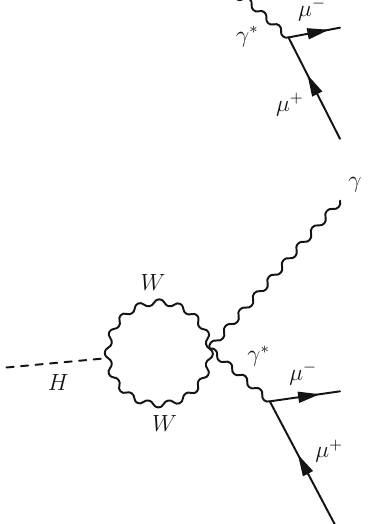
boson Dalitz decays, produced via ggF, VBF, VH modes for m H = 125 GeV, are simulated at NLO using the Mad- Graph 5_a mc@nlo generator interfaced with pythia 8.212 for parton showering and hadronization. The ttH contribution is accounted for by scaling the VBF signal to the ttH produc- tion cross section. The branching fraction for H → γ ∗ γ is obtainedfrom the mcfm 7.0.1program [43]. Theother source ofresonantbackgroundisthedecayofaHiggsbosonintotwo muons with a photon radiated from one of the muons. After the event selection, described in Sect. 4, the contribution of this background is